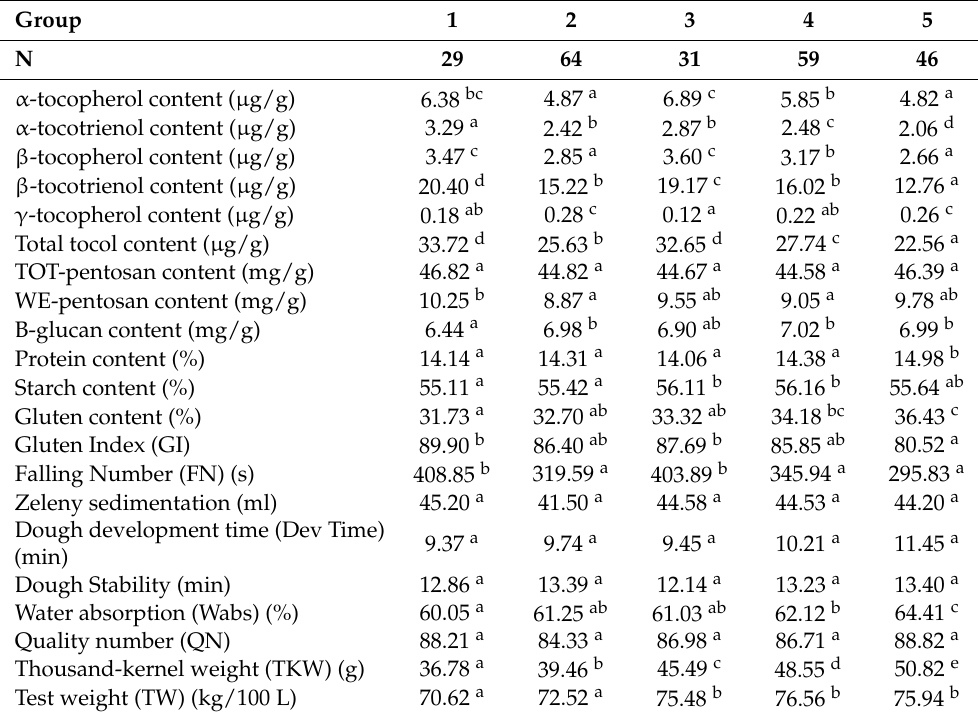
Table 3. Differences among the means of the five groups of the lines, determined by the hierarchical cluster analysis and evaluated by Tukey